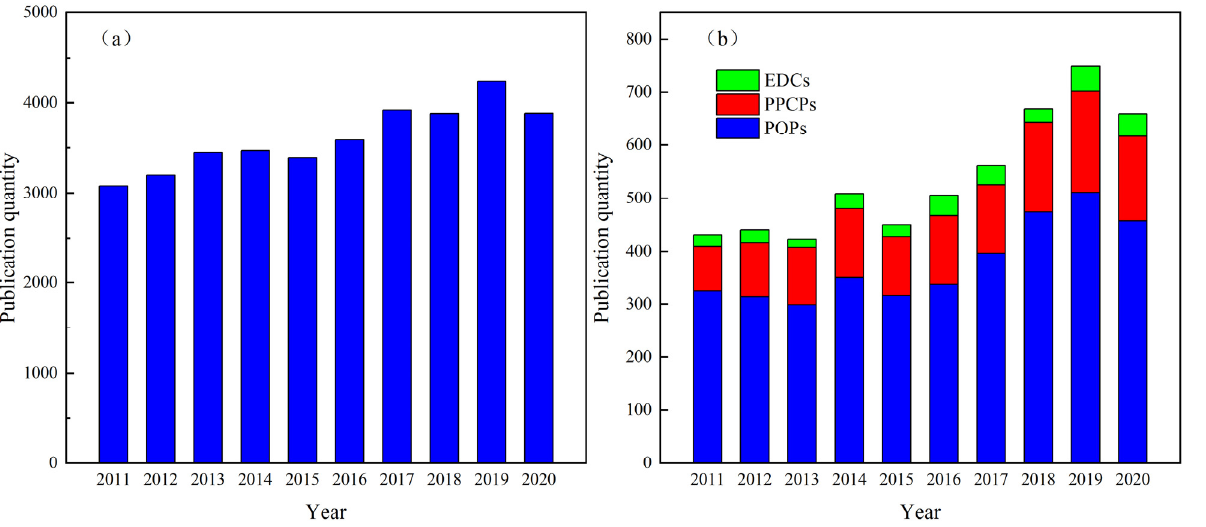
Figure 1. Statistics of papers about non-thermal plasma technology as a method for the degradation of ( a ) pollutants and ( b ) EOPs (EDCs, PPCPs, and POPs) published in the last ten years (data obtained from Web of Science).